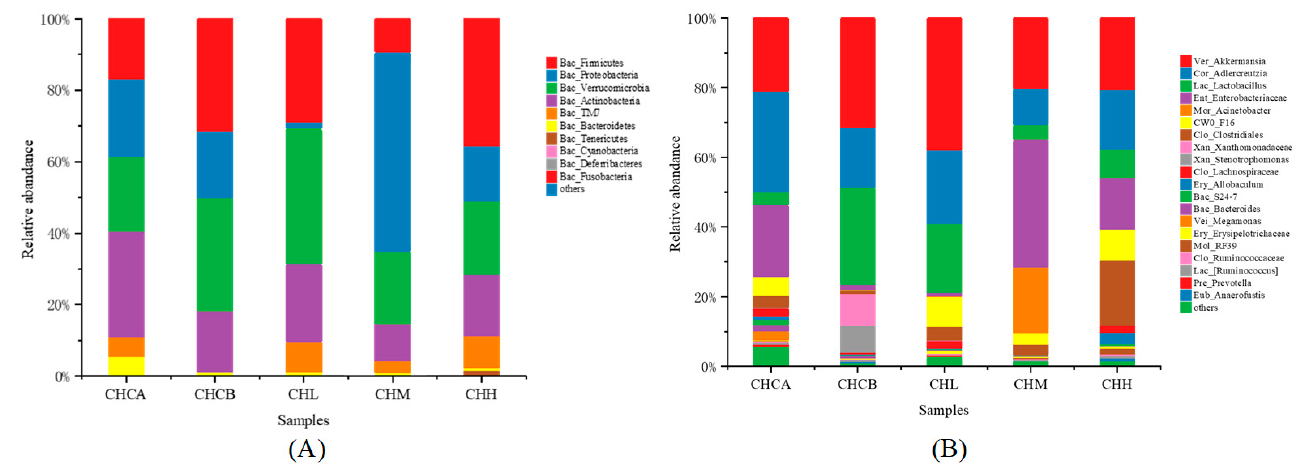
Figure 4. Effects of capsaicin and CIF on the composition and proportion of gut microbiota in mice. ( A ): At the phylum level, ( B ): At the genus level.